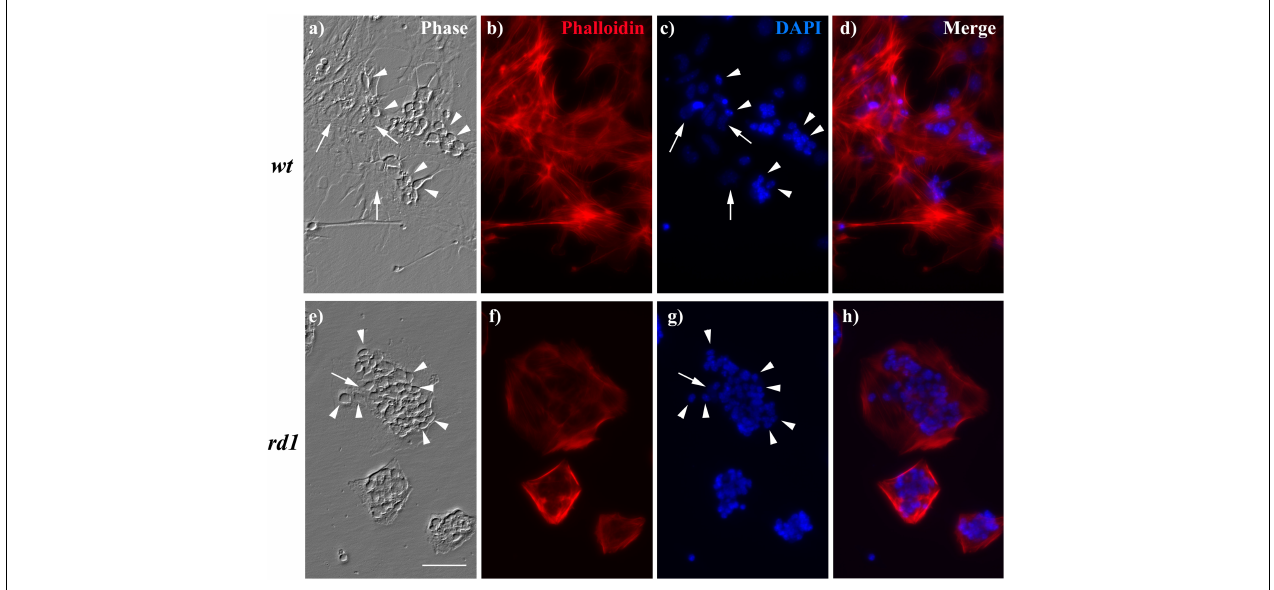
FIGURE 7 | MGC morphology and neuron:glial ratio was altered in rd1 mixed neuron-glial cultures. Phase (a,e) and fluorescence photomicrographs (b–d,f–h) of 6-day wt (a–d) and rd1 (e–h) mixed neuron glial cultures showing neuronal cells (arrowheads) growing on top of MGC (arrows). Actin cytoskeleton was stained with phalloidin (b,f) and nuclei with DAPI (c,g) . Merge pictures are shown in (d,h) . Scale bar: 50 µ